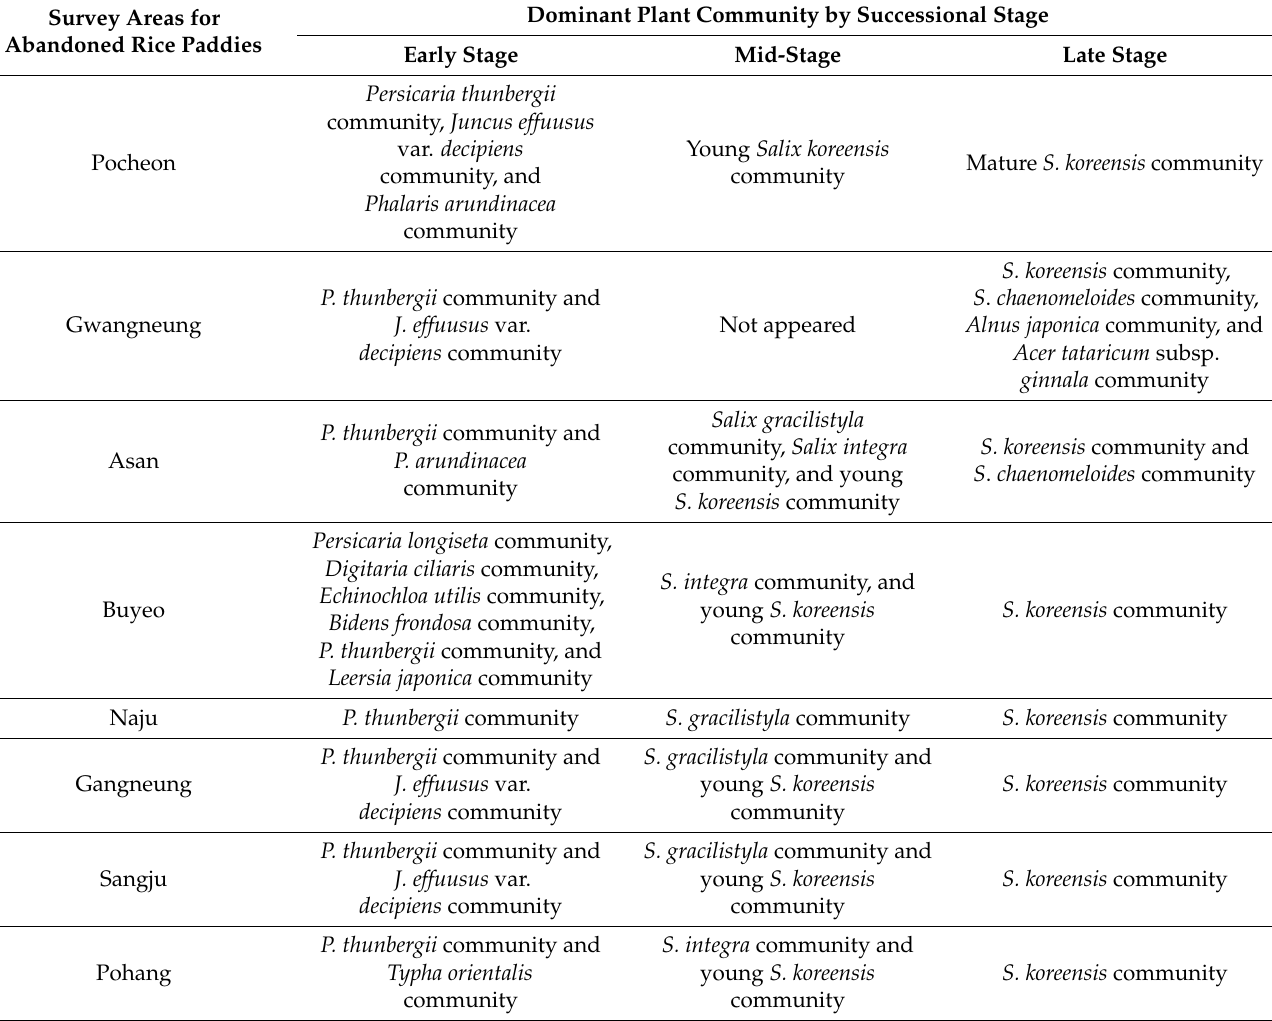
Table 3. Dominant plant communities by successional stage in survey areas for abandoned rice